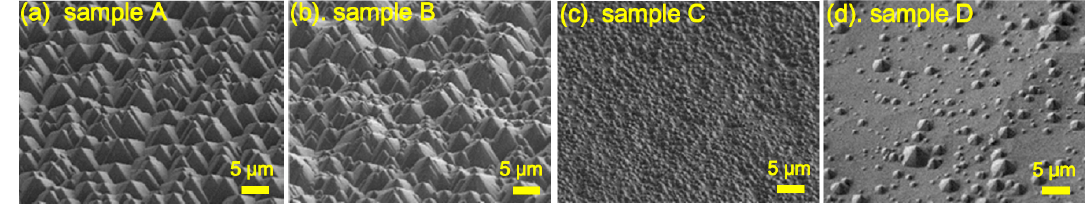
Figure 2. SEM images of rear-side of the silicon wafers with further polishing duration for: ( a ) 0; ( b ) 10; ( c ) 20; ( d ) 30 min.